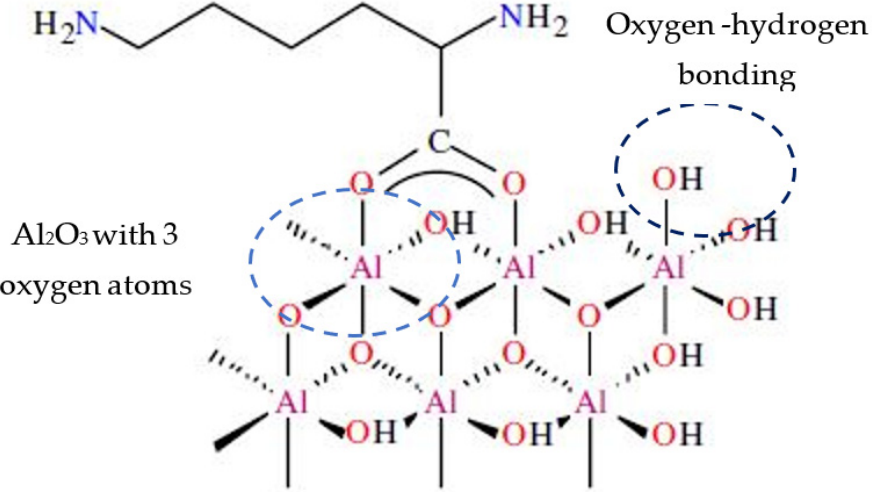
Figure 8. Polymeric reaction with Al 2 O 3 nanoparticles. Reprinted with permission from [48].